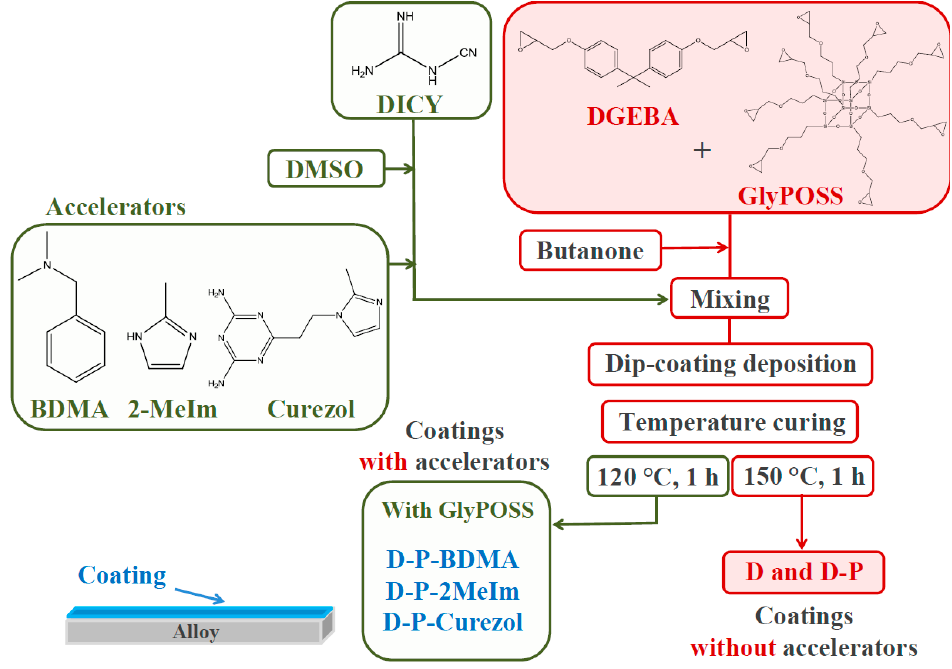
Figure 2. The preparation procedure of the protective coatings.